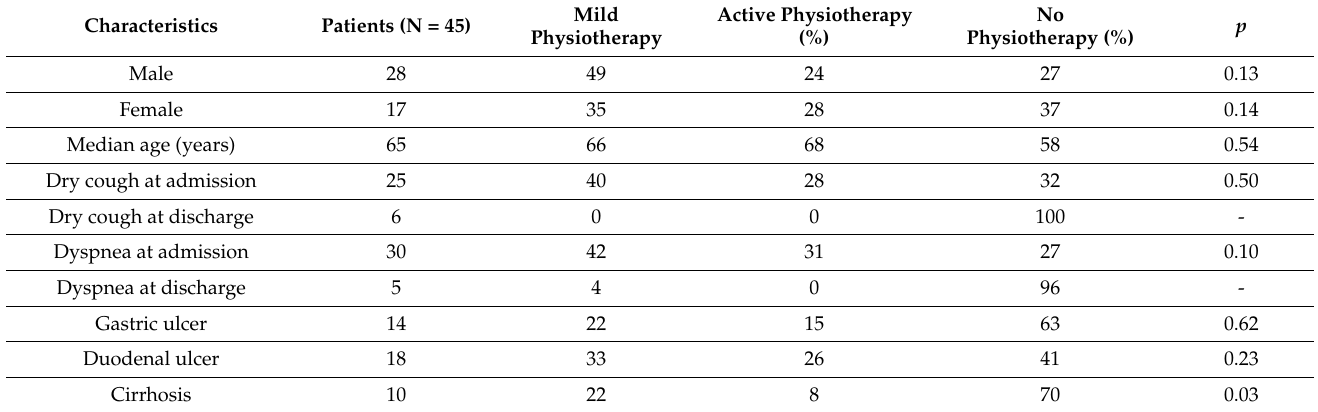
Table 1. Demographic and clinical characteristics of study